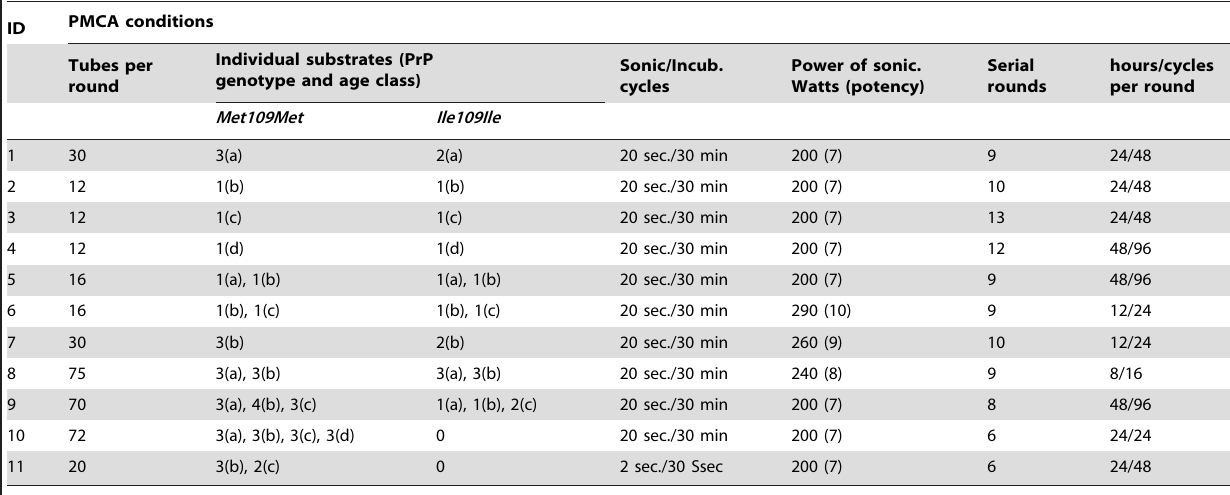
Table 1. Unseeded saPMCA experiments carried out in prion free laboratory.